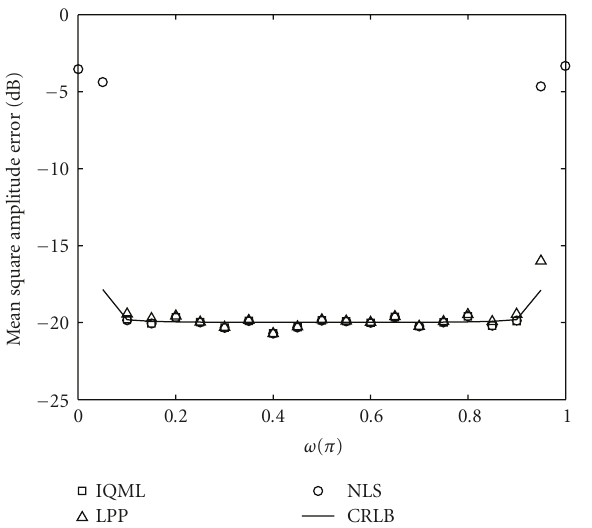
Figure 15: MSE for φ of single real sinusoid at SNR = 20 dB.